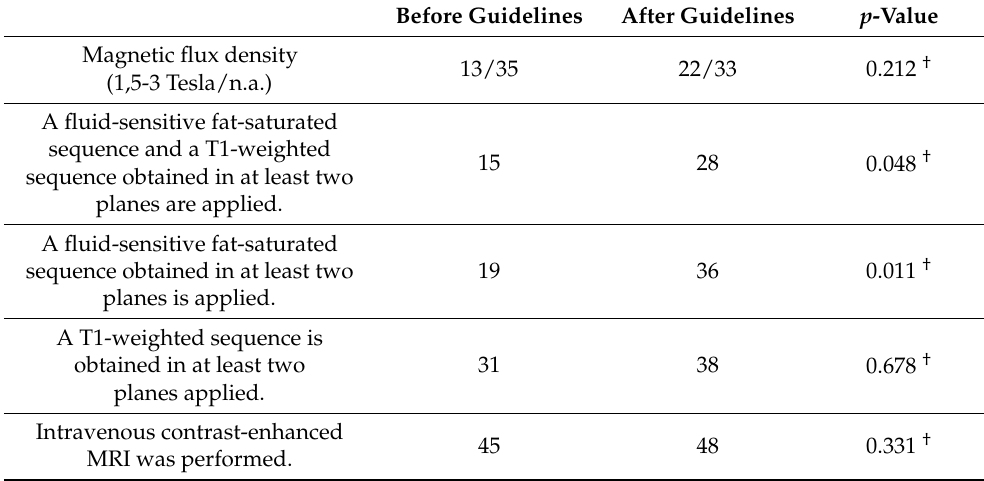
Table 3. Frequency of occurrence in technical criteria before and after guideline publication.